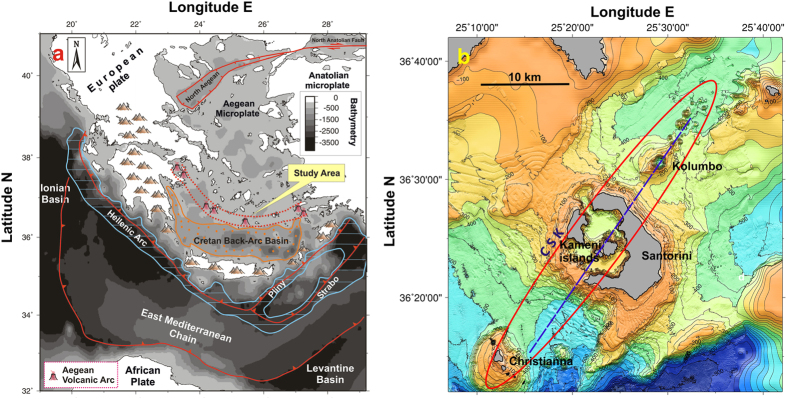
(a) Simplified map of the present day geodynamic structure of the HVA, showing the modern volcanic arc developed behind the Hellenic trench, the Peloponnese–Crete island arc and the Cretan back-arc basin. The study area is located in the center of the HVA (modified from ref. 28). (b) Swath bathymetric map of Christianna-Santorini-Kolumbo (CSK) volcanic fields (modified from ref. 26). The location of the NE-SW profile of Fig. 3 is also reported (purple dotted line), as well as CSK tectonic alignment.